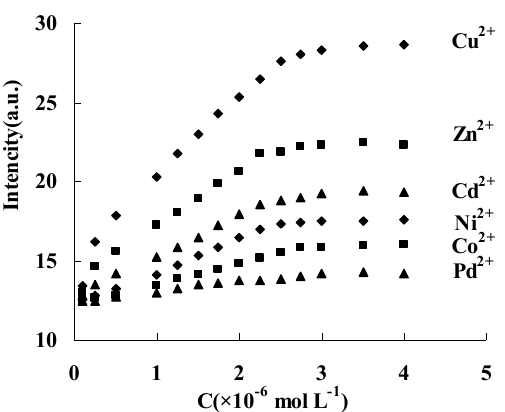
Figure 9. Effect of transition metal ions upon the fluorescence intensity of DAPD-SMP in ethanol at 385 nm, C DAPD-SMN = 20 mg·L − 1 , λ ex = 334 nm.